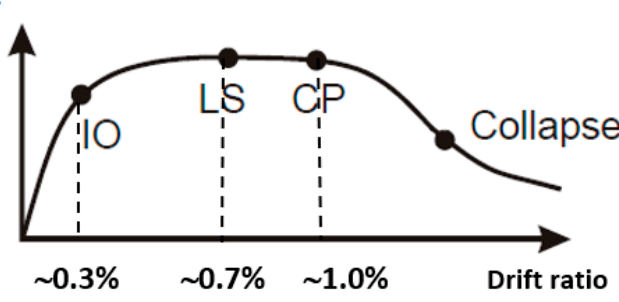
Figure 27. Pushover curve and limit states.